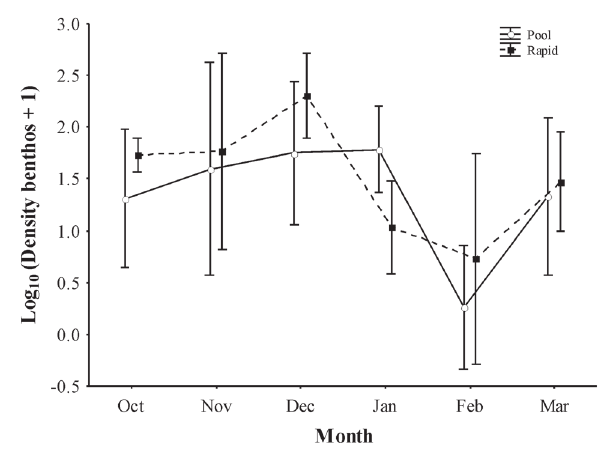
Fig. 7. Average density ± standard deviation of the spatio- temporal distribution of benthic organisms captured in the rapids and pool environments in the Peixe River, between the months of October 2011 and March 2012.